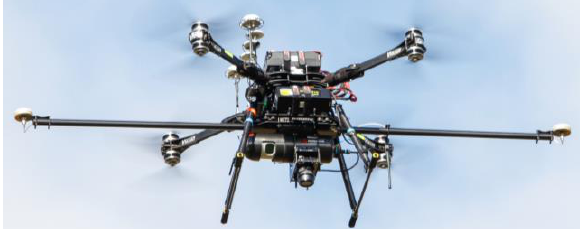
Figure 2. Vulcan Raven aircraft carrying Routescene UAV LiDAR System LidarPod and GNSS antennas, and Sony α6000